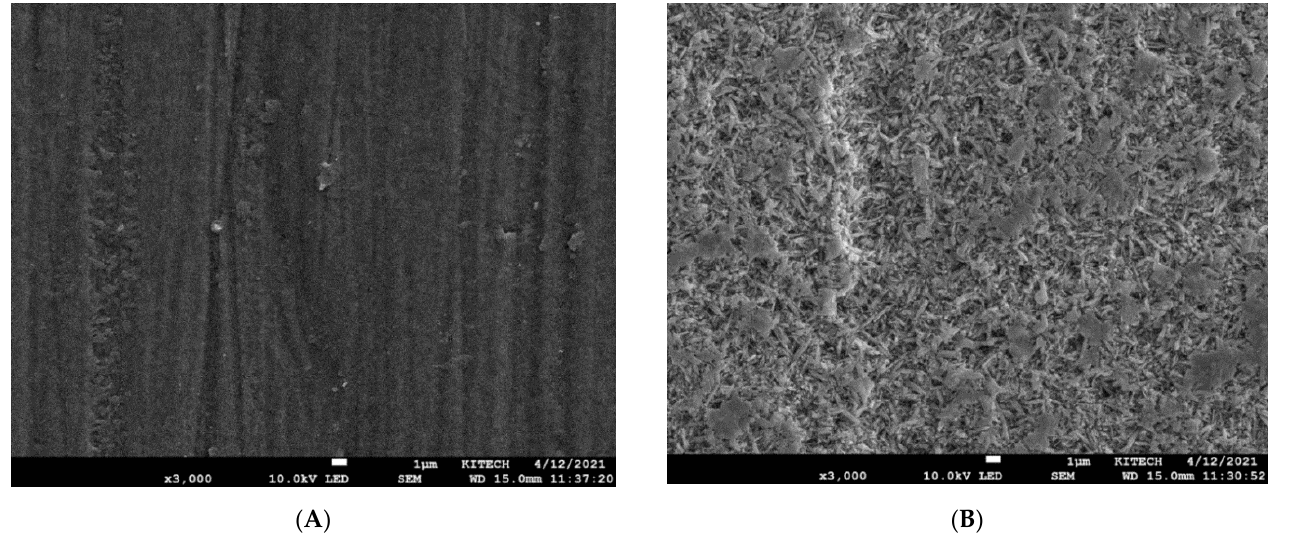
Figure 6. SEM images (×3000 magnification) of the LiSi press surface before ( A ) and after ( B ) treatment with 9.5% HF.